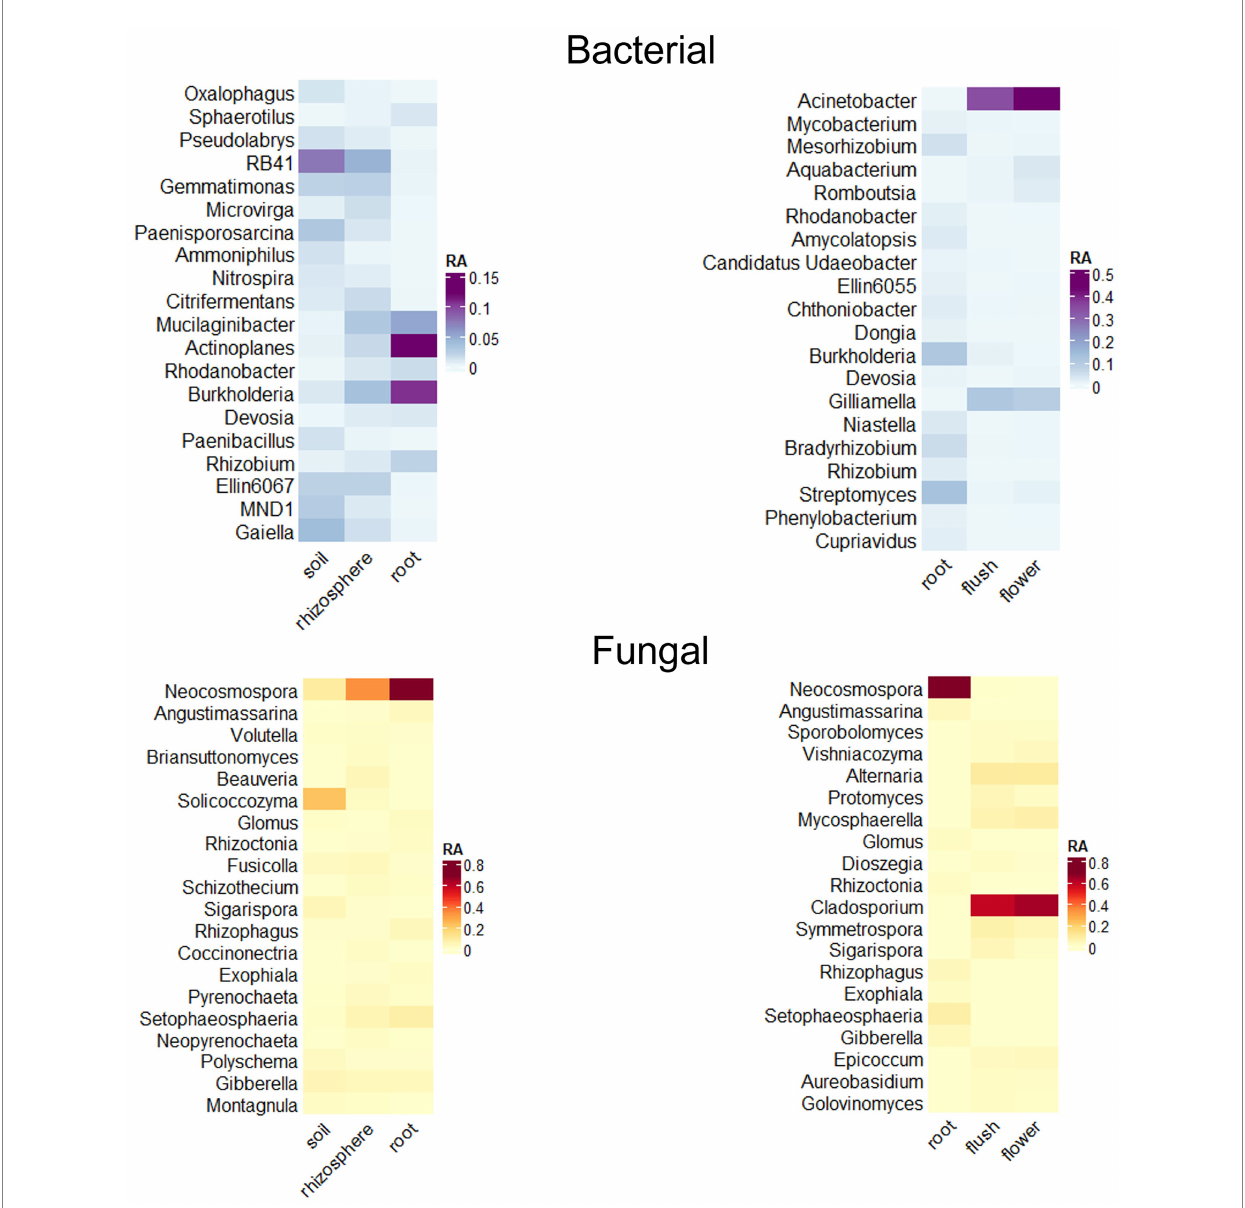
FIGURE 4 Relative abundance heat maps of significant taxa as determined through DESeq2 analyzes indicate recruitment of bacteria (top panels) and fungi (bottom panels) along the soil/rhizosphere/root endosphere axis (left panels) and signature taxa for the root/flush/flower (right panels) compartments. Data was filtered to a p < 0.01 cutoff and log2 fold change of > 5 or < − 5. Only genera occurring at ≥ 1% relative abundance with the top 20 highest log2 fold changes are